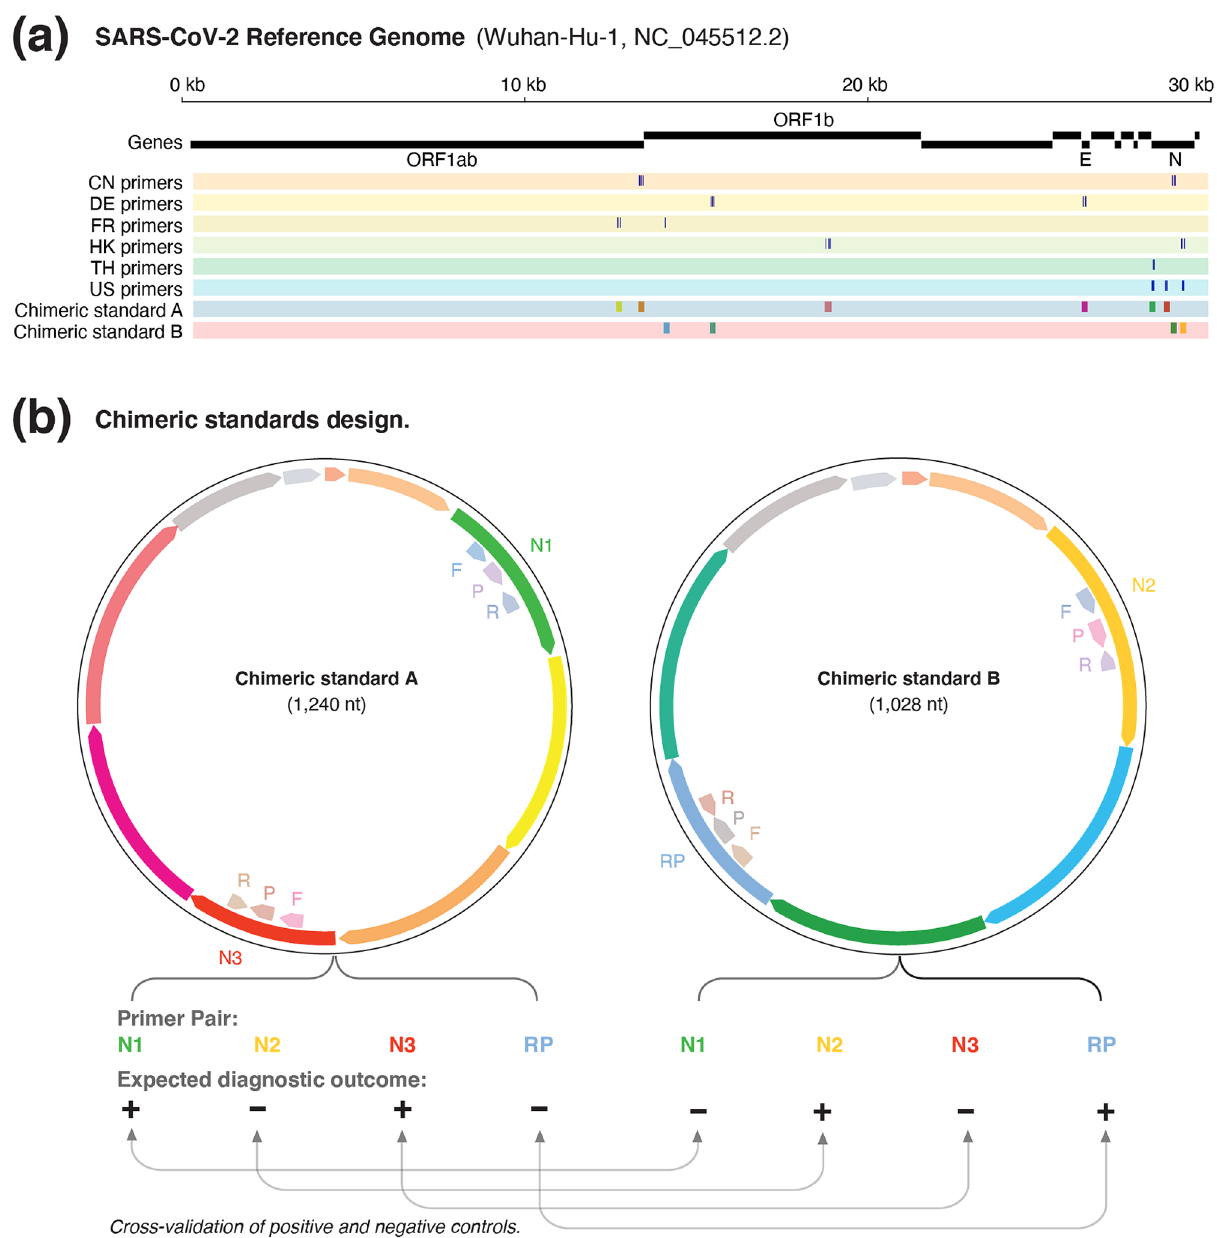
Figure 1. Design of chimeric controls for SARS-CoV-2. ( a ) View of the SARS-CoV-2 genome showing genes targeted by WHO-published real-time RT-PCR primer/probe sets (ORF1a, ORF1b, E and N genes). Specific binding sites targeted by different countries are shown in individual tracks (CN = China, DE = Germany, FR = France, HK = Hong Kong, TH = Thailand and US = United States). Targeted regions encompassing several primer/probe sets were selected and exclusively partitioned between chimeric A/B standards. The expected amplicons for the CDC test are shown in the last track. ( b ) The different targeted regions for standards A and B were shuffled and joined together to form chimeric sequences. The paired design of chimeric A/B standards, where a target in A is absent in B (and vice versa), enables the synthetic RNA transcripts to simultaneously act as positive and negative controls for the real-time RT-PCR primer/probe sets (F = forward primer, R = reverse primer and P = probe). This enables internal cross validation of positive and negative controls between standards A and B. The vector backbone was omitted from the representation of the chimeric A/B standards. The colours for targeted regions in the chimeric A/B standards are the same between figures ( a ) and ( b